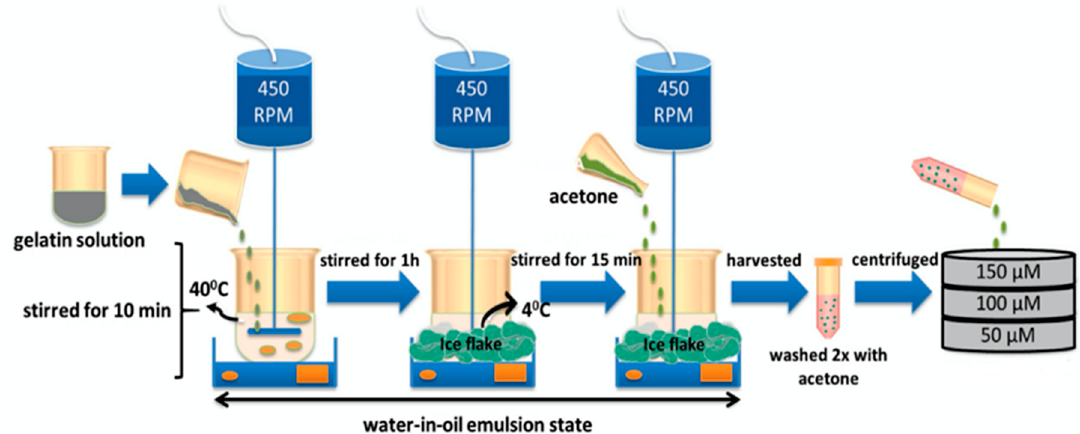
Figure 3. Water-in-oil emulsion method. An example of the method used to prepare gelatin